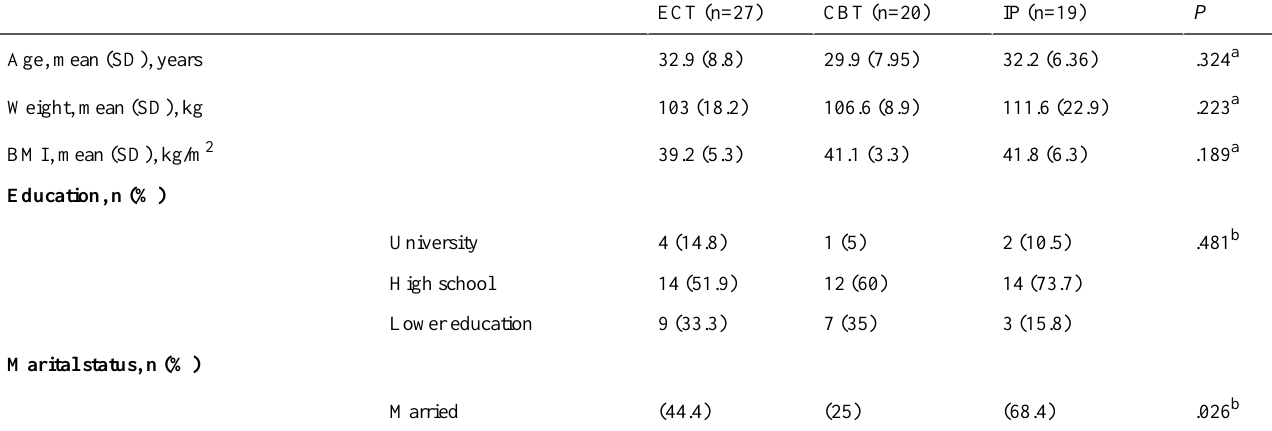
Table 1. Baseline